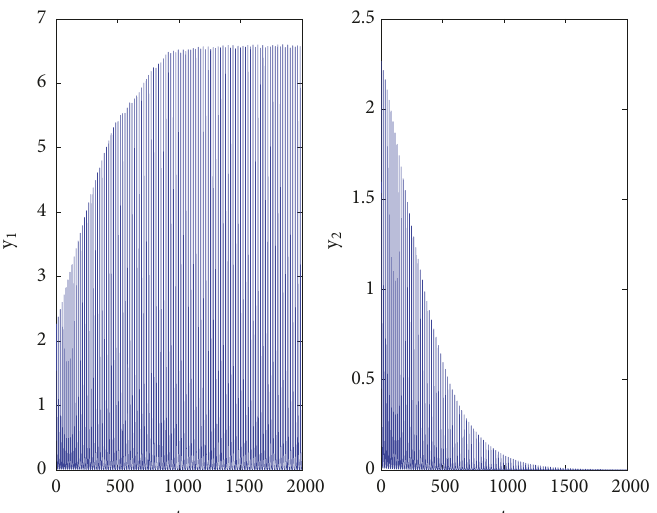
Figure 3: The simulated solutions of 𝐼 1 (𝑡) and 𝐼 2 (𝑡) under the condition 𝑟 = 1,𝑘 = 2,𝑏 1 = 0.8, 𝑎 1 = 1.2 , 𝑑 1 = 0.5 , 𝑏 2 = 0.8 , 𝑎 2 = 1.2 , 𝑑 2 = 0.5 and 𝑐 1 = 0.01 , 𝑐 2 = 0.02